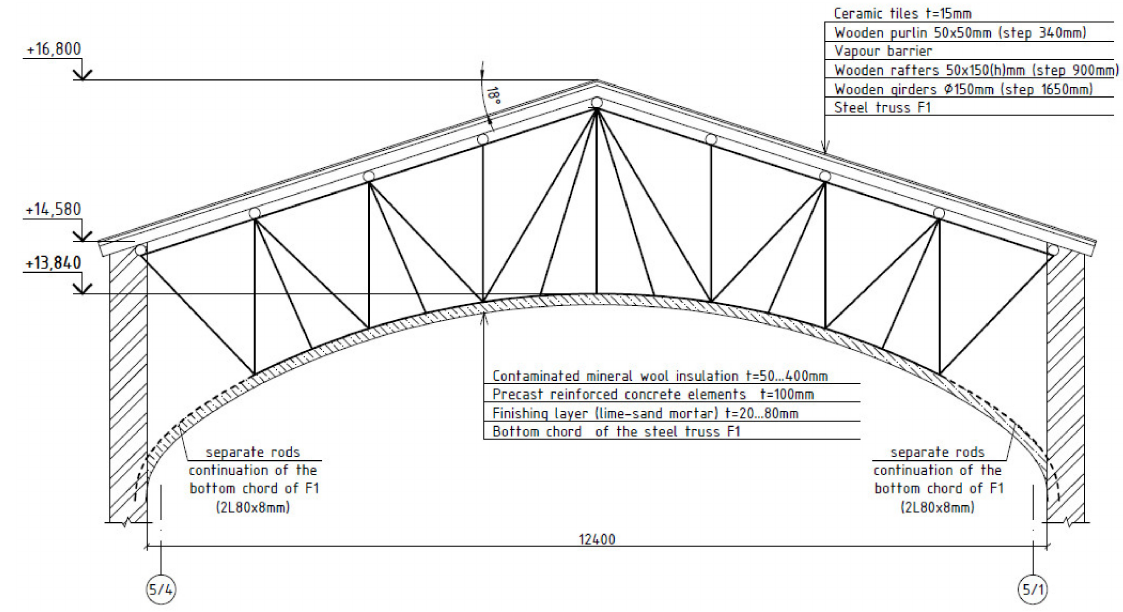
Figure 3. Schematic drawing of the